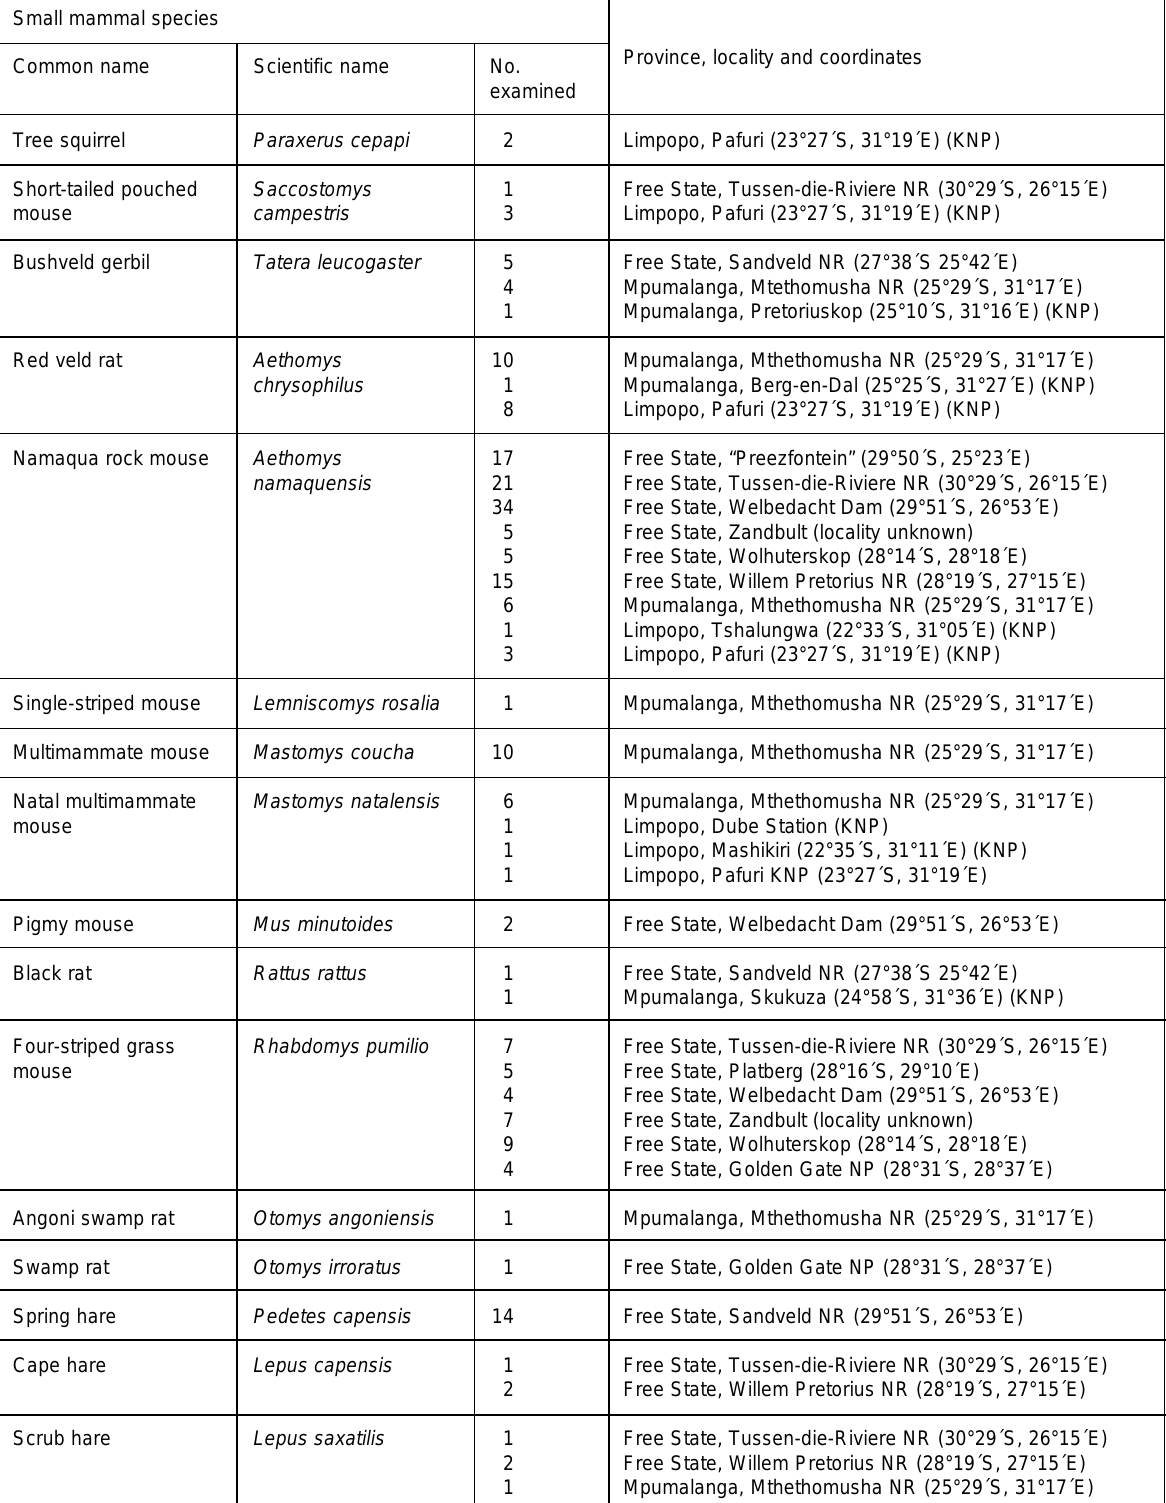
TABLE 1 Small mammals and the localities at which they were examined for ixodid